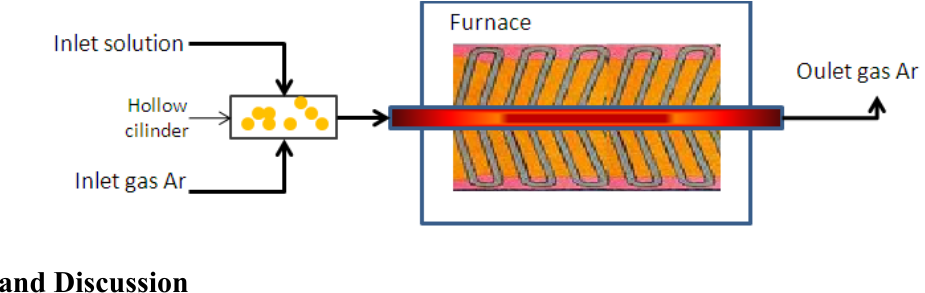
Figure 1. Schematic diagram of reaction system for the synthesis of CNTs by spray pyrolysis.